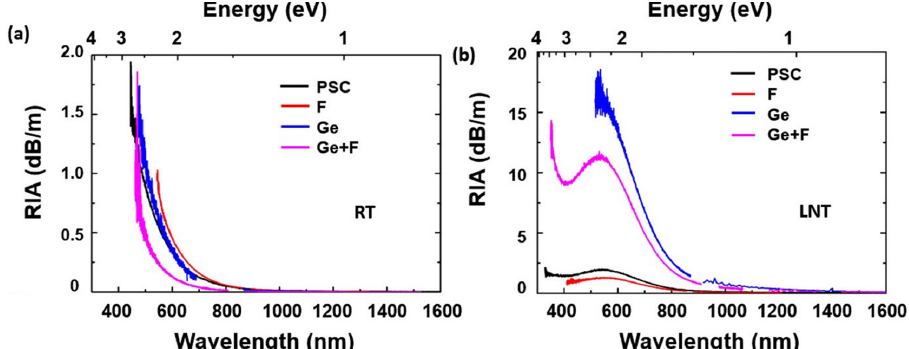
Figure 14. RIA under x-ray pulse after 1 s of different fibers: pure silica core (PSC OF), F-doped, Ge-doped, and Ge + F- doped fibers. ( a ) RIA at room temperature; ( b ) RIA at liquid nitrogen temperature [122].